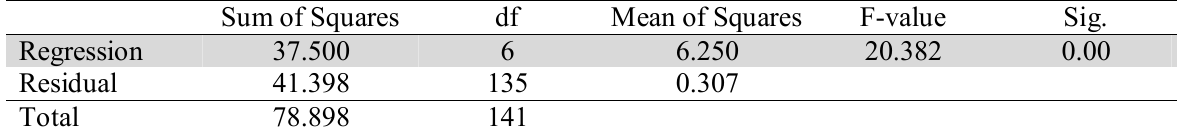
The summary of ANOVA test for testing the third